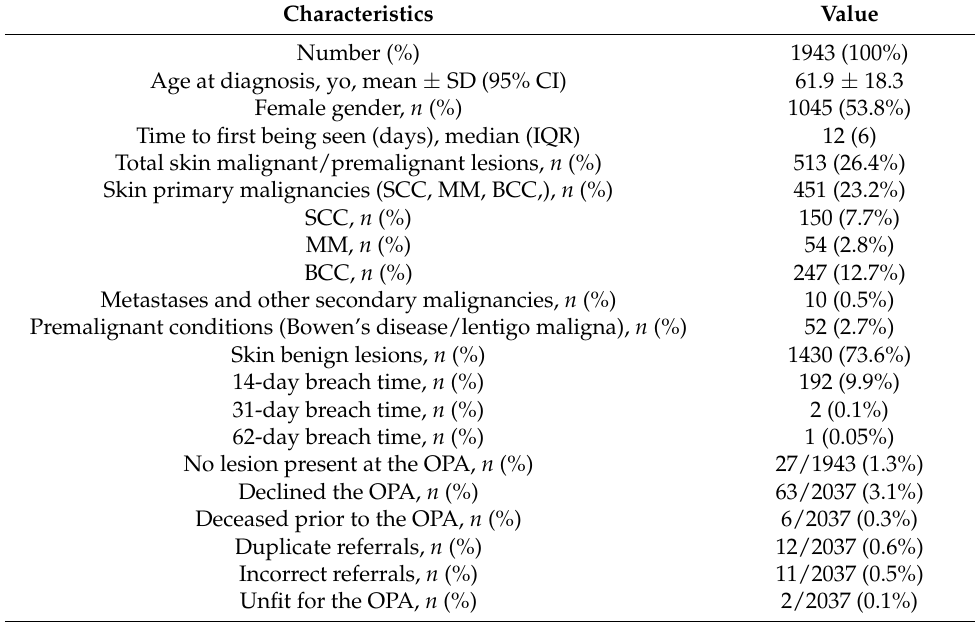
Table 1. Key baseline characteristics of the two-week wait pathway patients ( n =